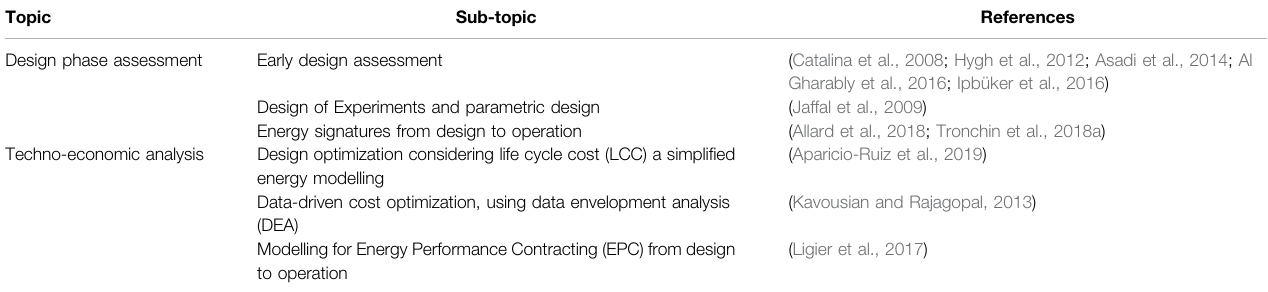
TABLE 2 | Regression-based approaches for design phase performance assessment and techno-economic